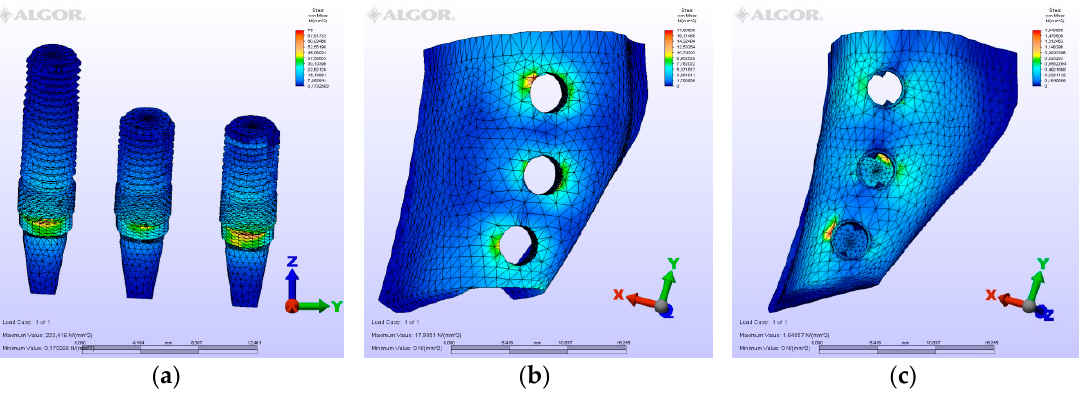
Figure 9. Model M3, oblique loading. ( a ) the maximum von Mises stresses around implants; ( b ) maximum principle stress in cortical bone; ( c ) maximum principle stress in cancellous bone.